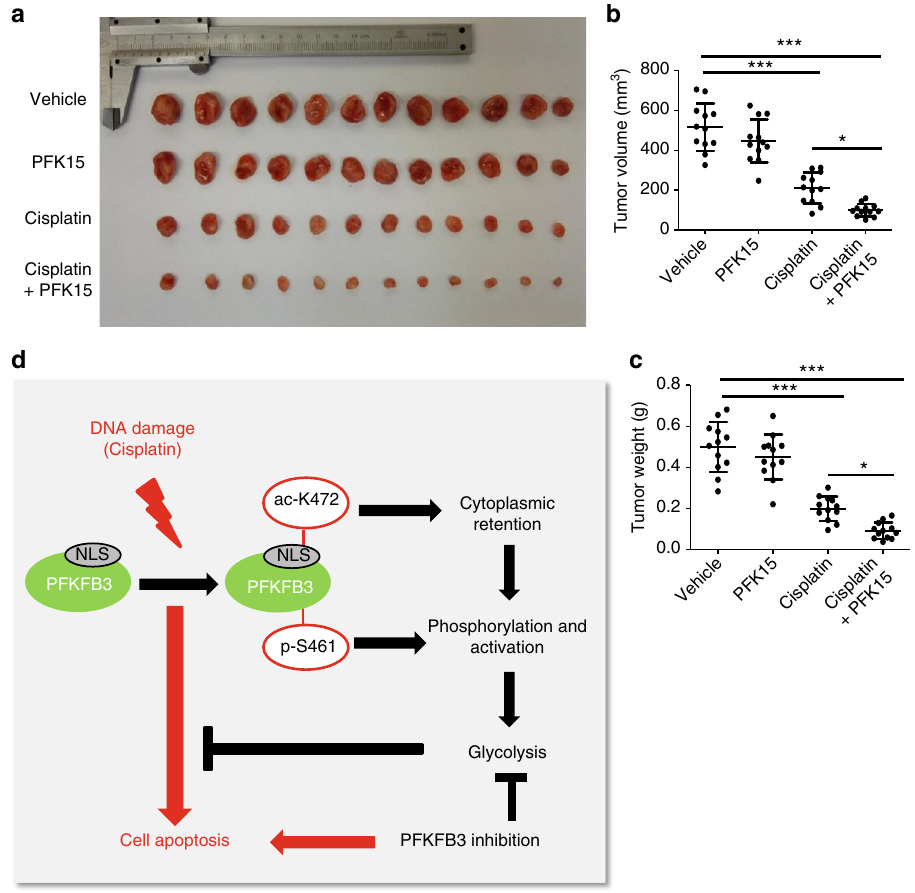
Fig. 8 Inhibition of PFKFB3 cooperates with cisplatin to inhibit xenograft growth. a Combined use of cisplatin and PFK15 is more ef fi cient in inhibiting xenograft tumor growth than single treatment. Xenograft experiment followed by cisplatin or PFK15 injection was described in the Methods section. Xenograft tumors were collected and photographed. b , c Quanti fi cation of b average volume and c weight of xenograft tumors from a is shown. Twelve tumors from individual mice were included in each group. Data are presented as mean ± s.d., and statistical analyses were performed by using one-way ANOVA with Bonferroni ’ s post-test. * P < 0.05 and *** p < 0.001 for the indicated comparison; n.s., not signi fi cant. d A working model that PFKFB3